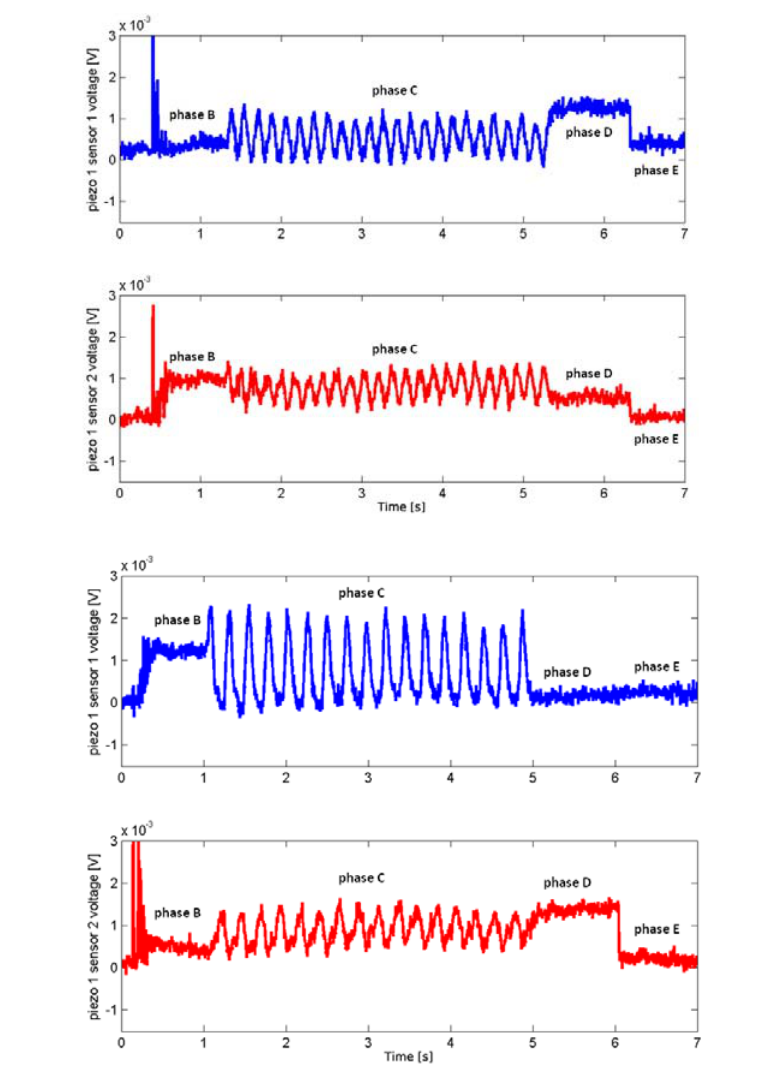
Figure 9. Time plot of the readings from piezoresistor 1 of MEMS sensors 1 and 2 of the array. The plots refer to data series 1 (a) and 31 (b), where gratings of 3.6 mm and 2.6 mm spatial periodicity were applied with translational speed of 15 mm/s, respectively, according to Tables 2 and 3. The frequency modulation due to the variation of the stimulus can be easily appreciated. The steps corresponding to the loading and unloading of the stimulus (phases A-B and D-E) may be more or less evident in a specific unit of the array depending on whether the ridge of the stimulus falls under a sensor unit or not, showing the static imaging potentiality of the tactile sensor